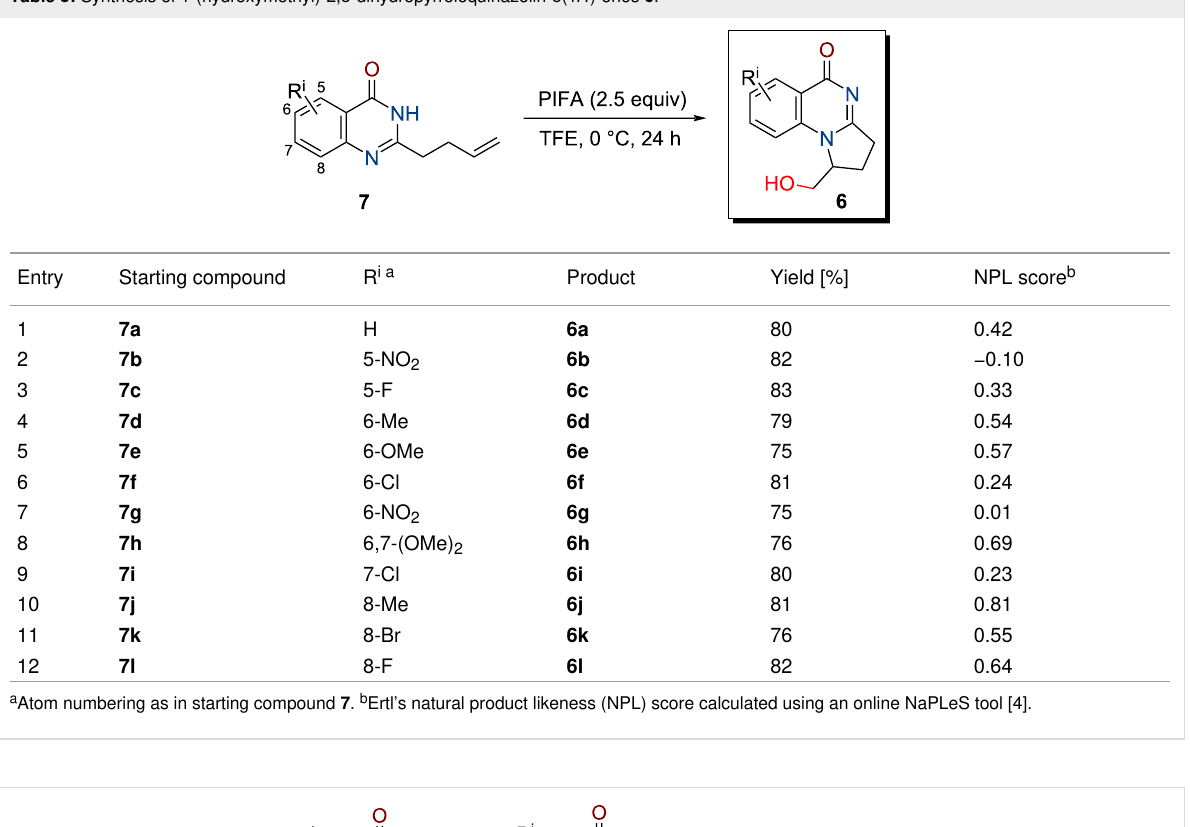
Table 3: Synthesis of 1-(hydroxymethyl)-2,3-dihydropyrroloquinazolin-5(1 H )-ones 6